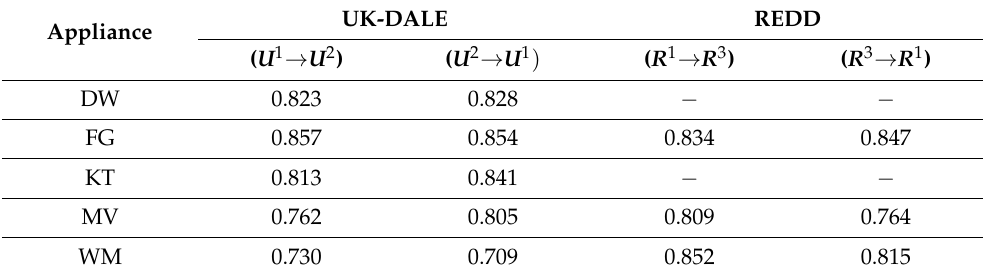
Table 4. F1 score comparison of TCN + gkMMD domain adaptation within the same dataset.